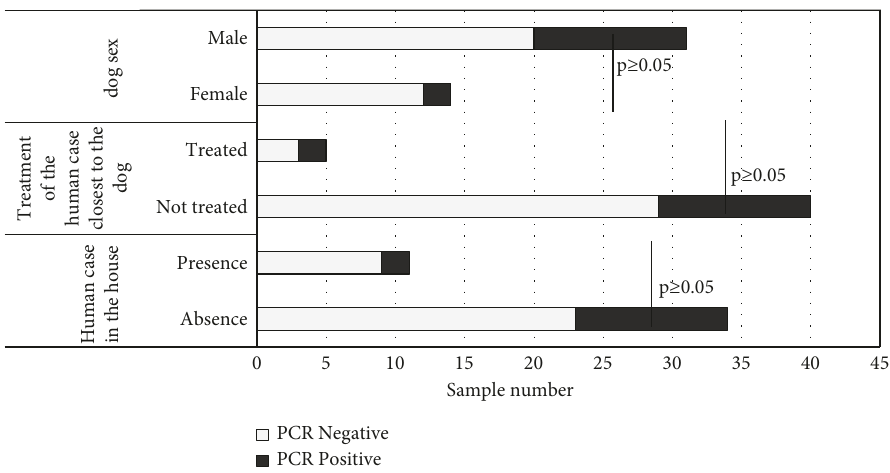
Figure 3: Bivariate comparison between risk factors and infection by Leishmania